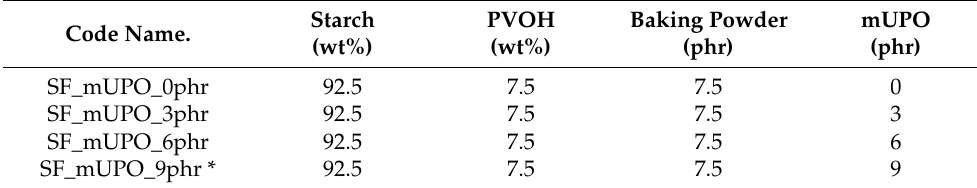
Table 1. The formulation of non-glutinous starch foam. Code